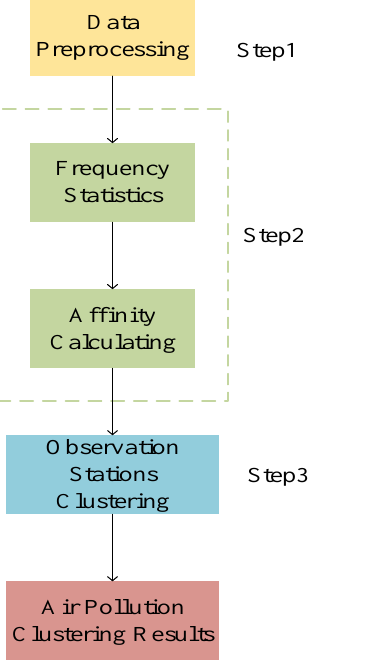
Fig. 1. Air Pollution Observation Stations Clustering Flow Chart.